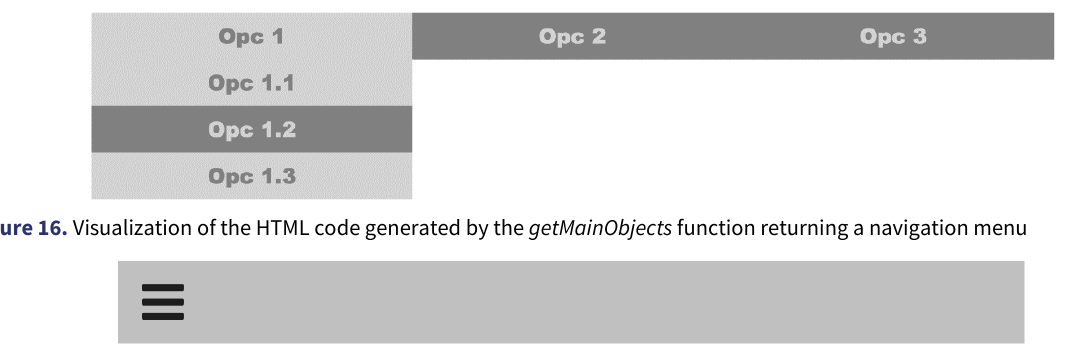
Figure 17. Visualization of the navigation menu with a screen width less or equal 800 pixels. The menu is transformed in a button with the options closed. It is possible to click in the button to show the options